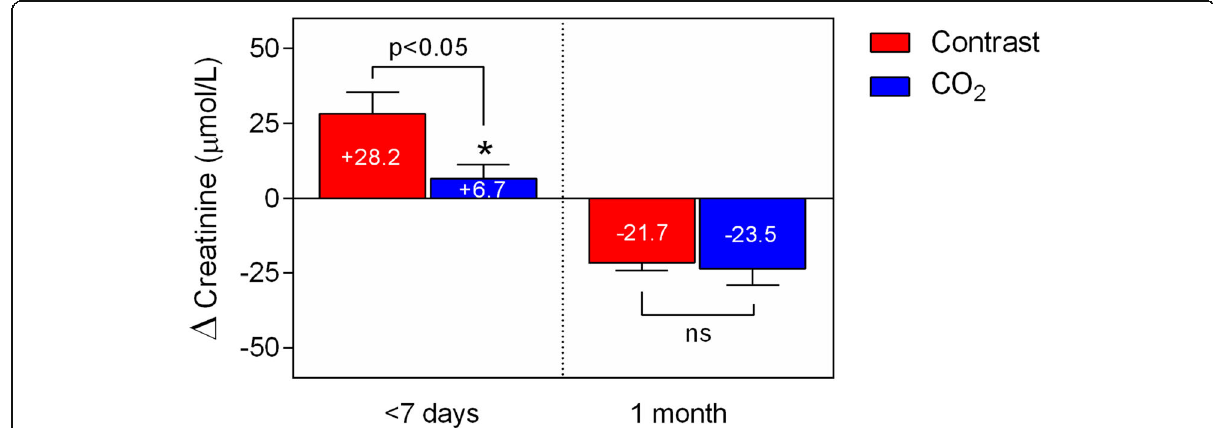
Fig. 2 Serum creatinine differences ( Δ ) in the immediate post-procedure period and 30 days post-intervention. CO2 (blue bars) and control (red bars) groups